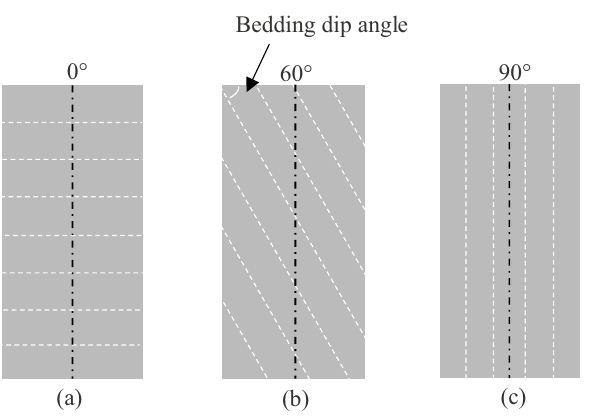
Figure 3. Plots of shale specimens cored from a shale block with different bedding dip angles ( θ ): ( a ) 0°, ( b ) 60° and ( c ) 90°.